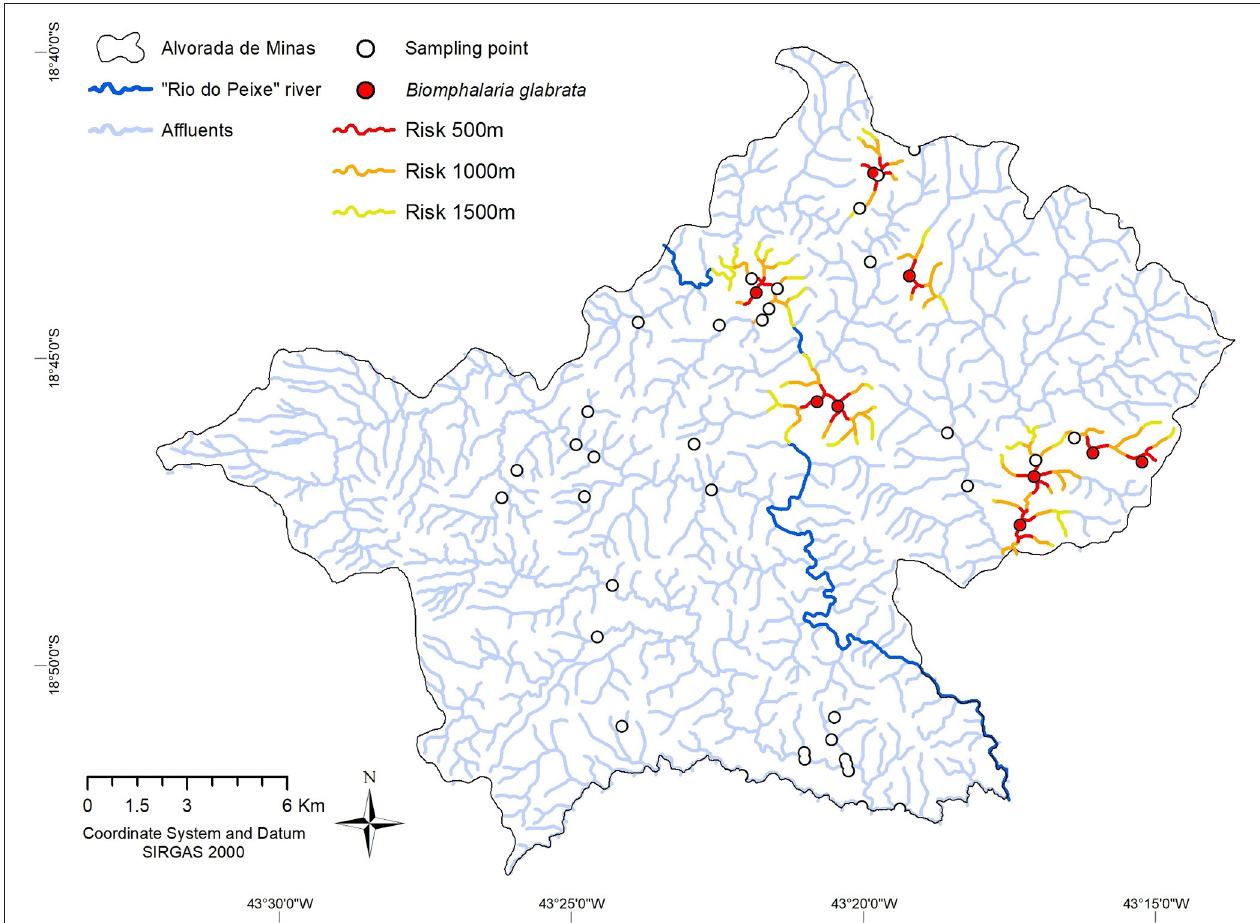
FIGURE 5 | Distribution of Biomphalaria glabrata habitats and risk zones, according to Buffer estimates, in the period from 2018–2019, Alvorada de Minas, Minas Gerais State, Brazil. Collection points with B. glabrata (red circles) and buffer risk zones for downstream or upstream waterbodies for 500 meters (red), 1,000 meters (orange), and 1,500 meters (yellow)